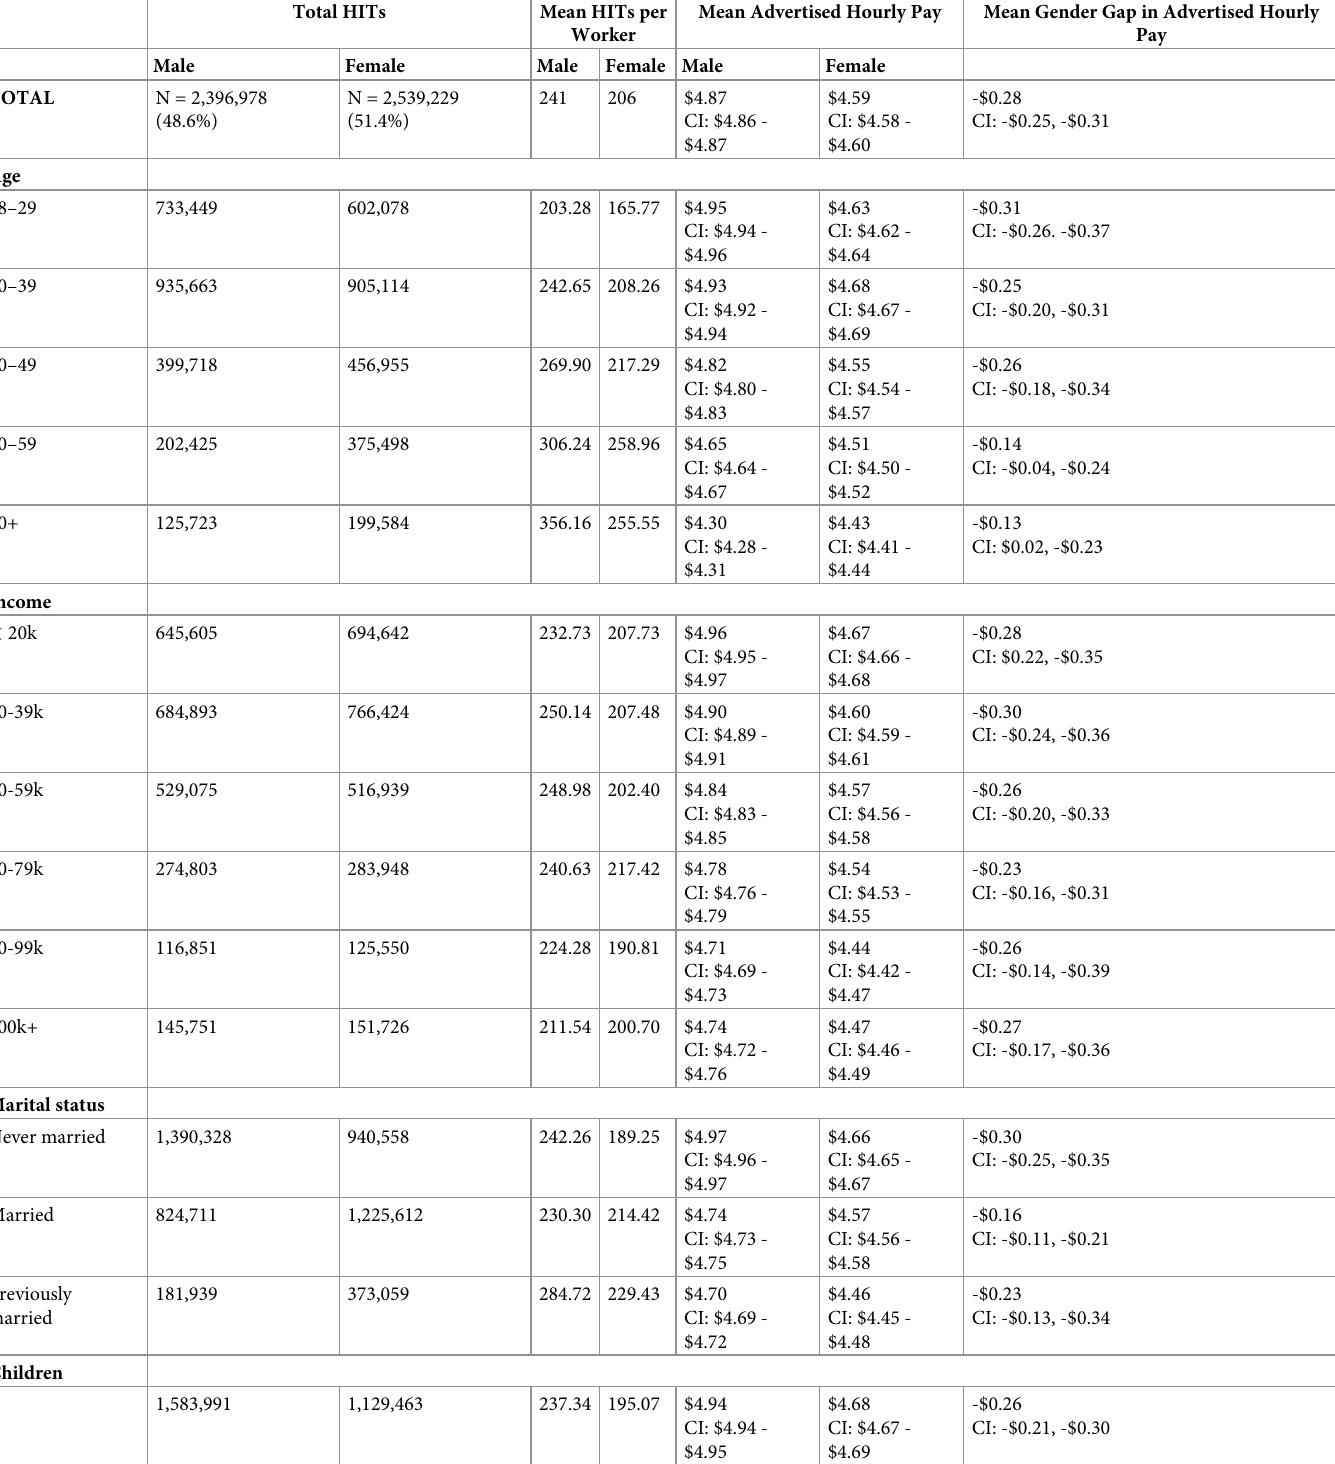
Table 4. Characteristics of MTurk workers in the CloudResearch database and the distribution of HITs, average advertised hourly pay, and gender pay gaps by indi- vidual-level